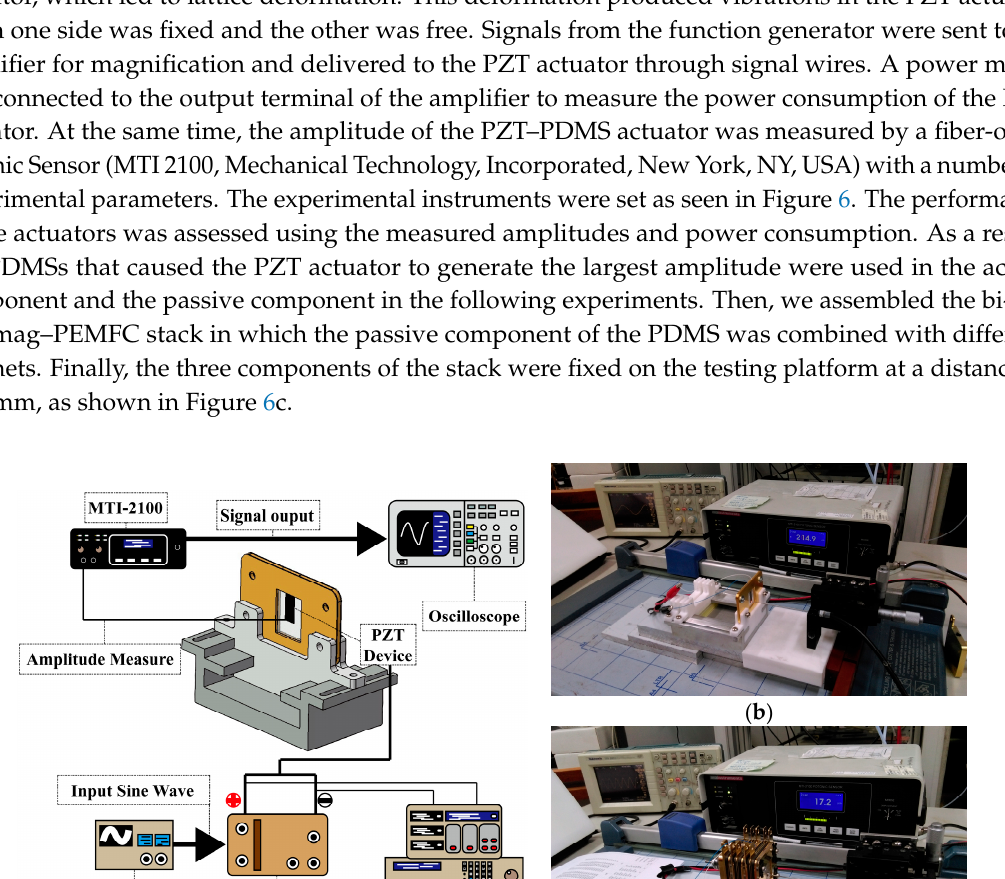
Table 2. Mechanical properties of PDMS diaphragm with different curing times.